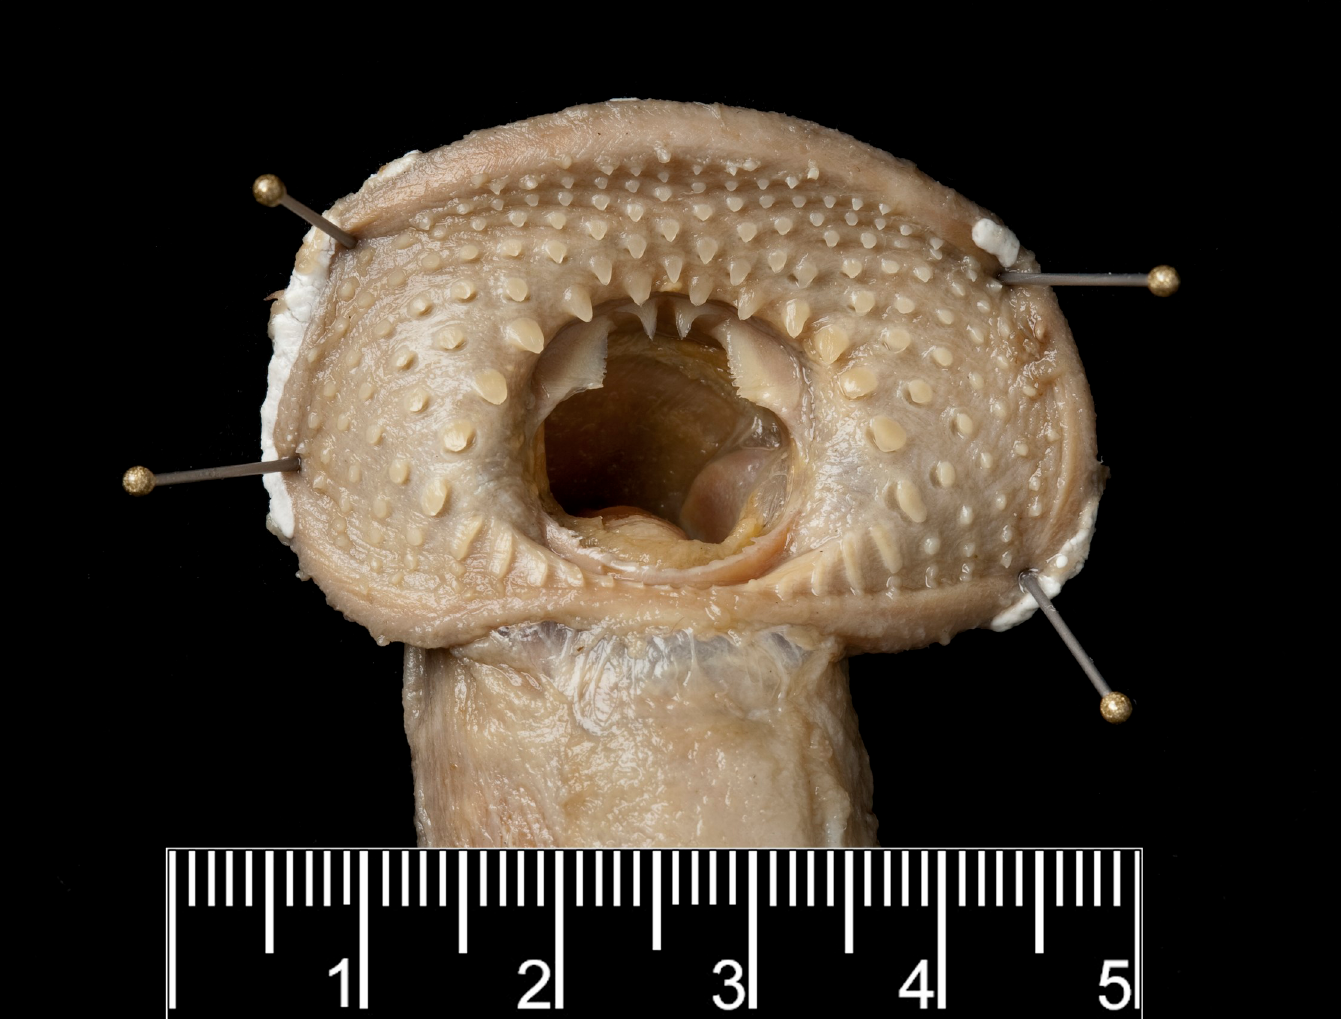
Fig 13. Oral disc of mature adult holotype of Geotria allporti (BMNH 1871.8.18.51) without any ridges of epithelium flanking the labial teeth. Note the serration along the inner edge of both lateral flanges of the supraoral lamina reported by Gu¨nther [45] in the original description. Photographed by Phil Hurst, Photographic Unit, © The Natural History Museum,